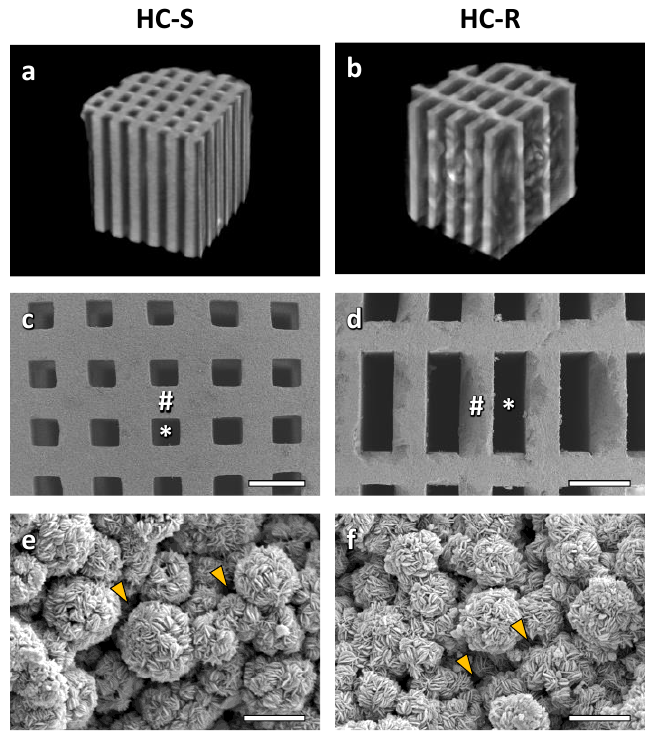
Figure 1. Micro-computerized tomography ( µ -CT) cross-section images of honeycomb scaffolds with square channels (HC-S) ( a ) and honeycomb scaffolds with rectangle channels (HC-R) ( b ). Scanning electron microscopy (SEM) images of HC-S ( c ) and HC-R ( d ). Scale bars, 500 µ m. # and * indicate struts and channels, respectively. Higher magnification SEM images of the struts in HC-S ( e ) and HC-R ( f ). Scale bars, 5 µ m. Yellow arrowheads indicate micropores between carbonate apatite (CAp) spheres.